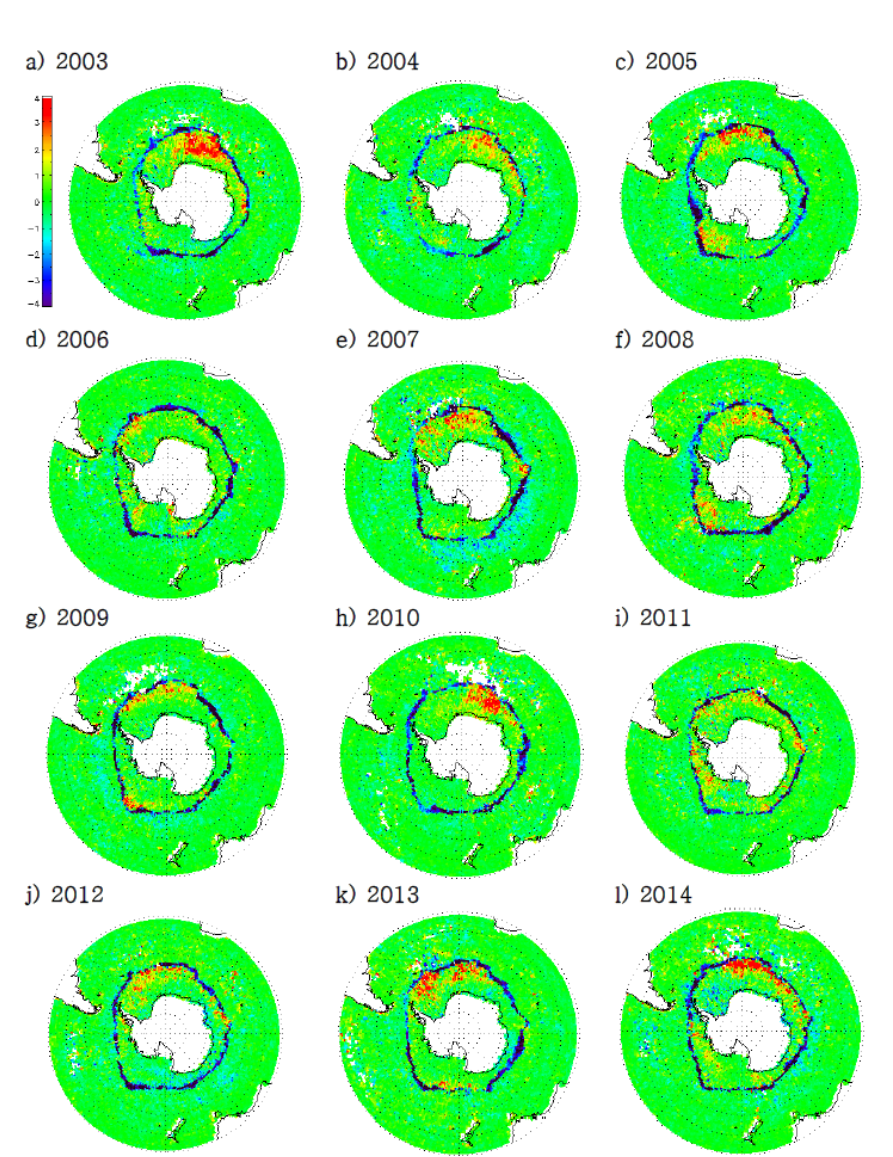
Figure 6. Same as Fig. 5 except for T skin (AO_V6) minus T skin